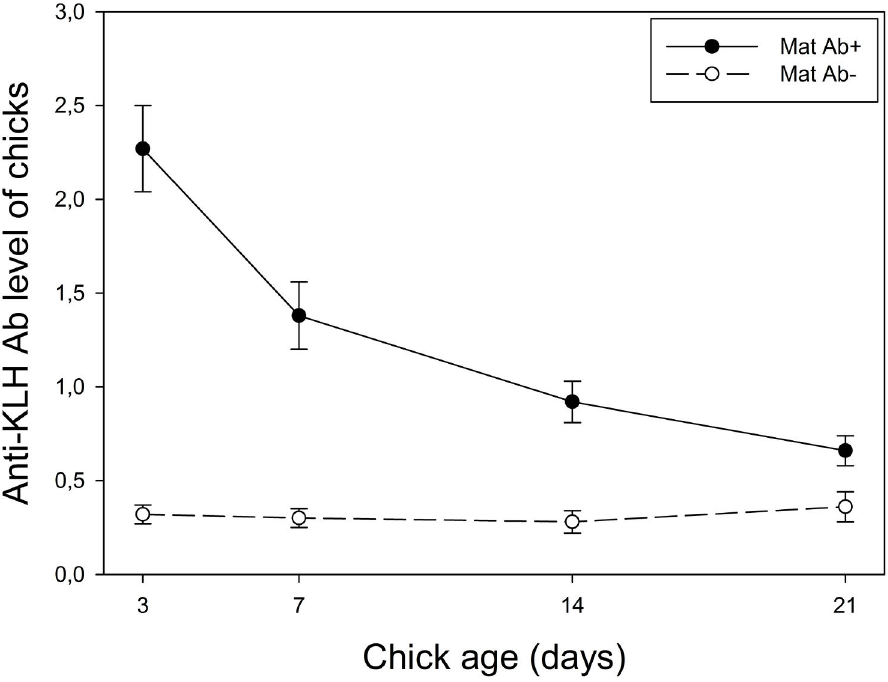
Figure 2. Persistence of maternal anti-KLH Abs in chicks as they age. For illustrative purposes, we split the chicks into two categories on the basis of the median 3-day-old anti-KLH Ab level: chicks that have received high levels of maternal anti-KLH Abs (Maternal Ab+; above the median) are represented by black dots and chicks that have received low levels of maternal anti-KLH Abs (Maternal Ab-; below the median) are represented by white dots. doi: